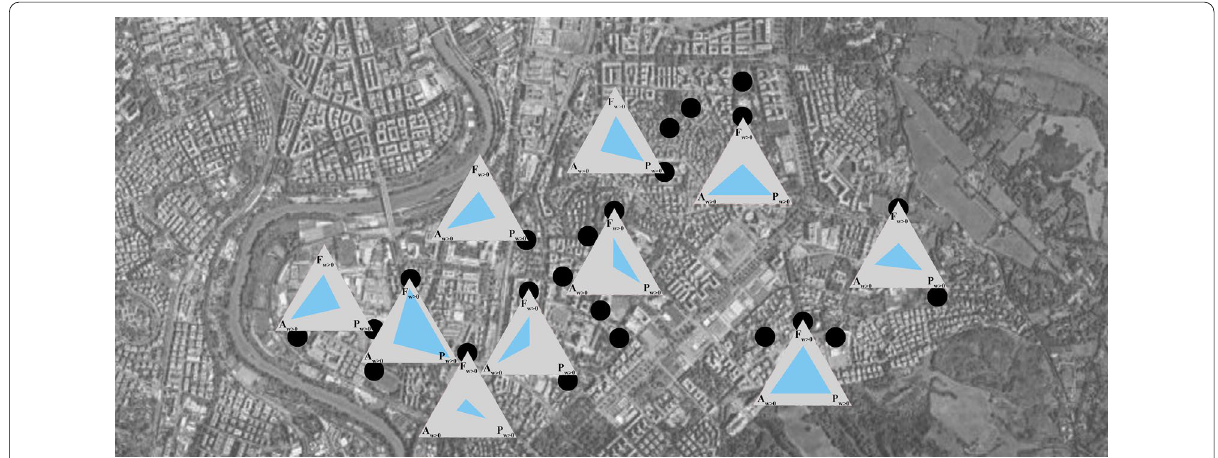
Fig. 10 The procedure applied at